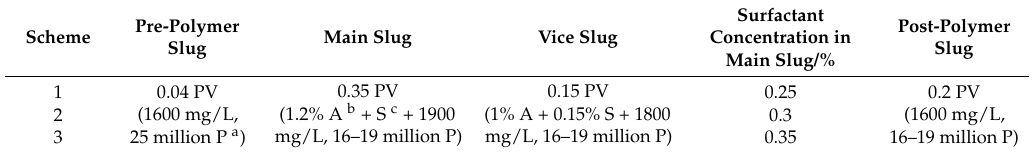
Table 6. Concrete schemes of the oil displacement with different surfactant concentrations in the main slug.